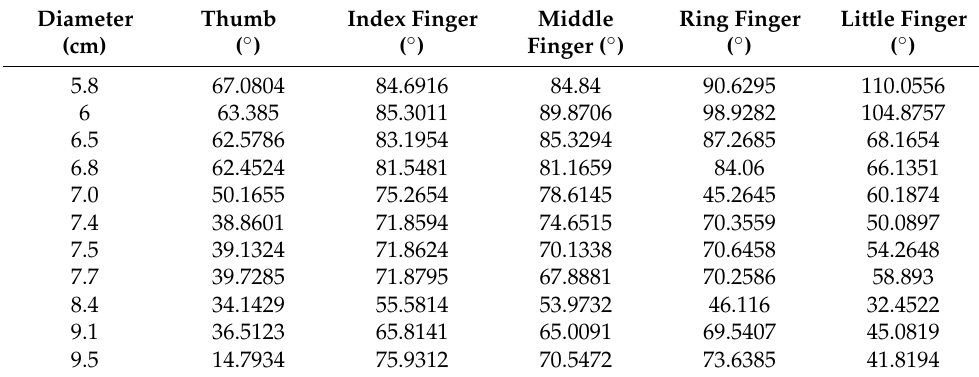
Table 2. Finger curvature under stable grasping of objects with different